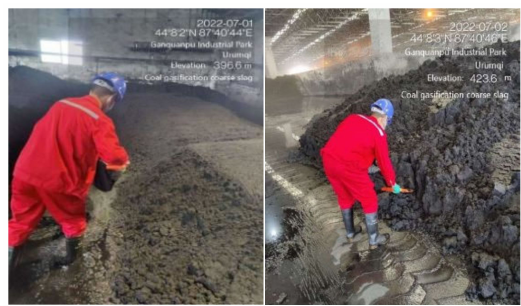
Figure 1. Photos of field